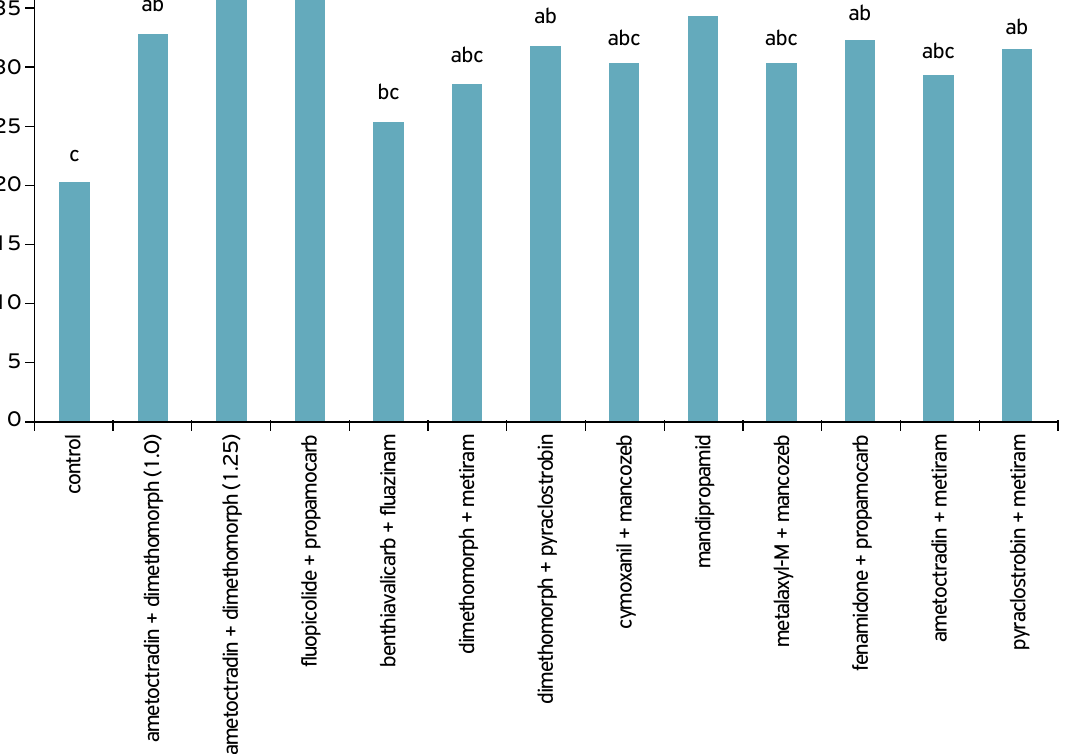
Figure 4. Yield (ton/ha) of potato plants (cultivar Ágata) treated with fungicides. Pilar do Sul, São Paulo,